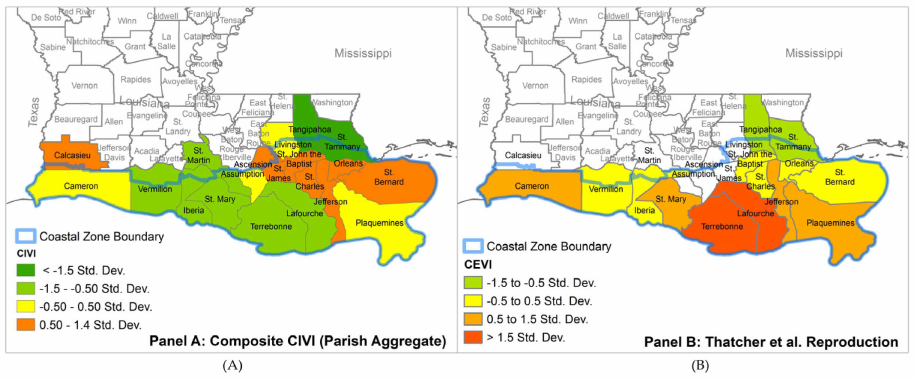
Figure 5. Comparison of CIVI results to the CEVI results of Thatcher et al. [19] (Parish level aggregation). ( A ) Composite CIVI (Parish aggregation); ( B ) Thatcher et al.